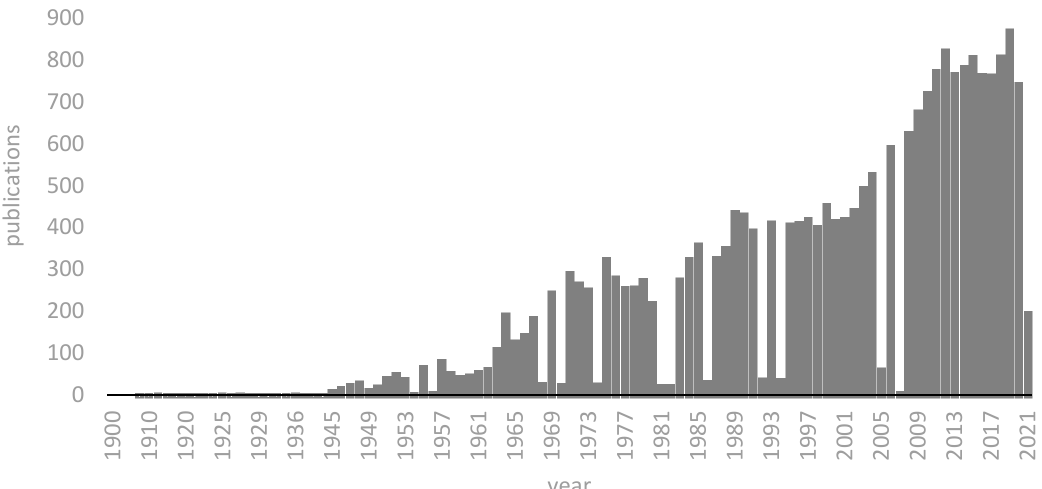
Figure 1. A time bar of the publications on Co intoxication available on PubMed across time.